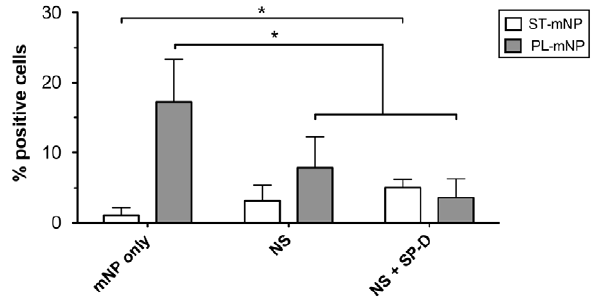
Figure 8. Association of nanoparticles with alveolar macro- phages in dependence on native surfactant. Starch- (ST) or Phosphatidylcholine-modified (PL) magnetite nanoparticles (mNP; 1.532 6 10 10 /ml) were incubated with alveolar macrophages (MH-S cells) for 90 min in absence (mNP only in buffer) or presence SP-A containing Native Surfactant (NS; 100 m g/ml total protein) with and without 6 m g/ ml SP-D (NS + SP-D). Per cent of cells with Fl-1 . 10 1 were considered as positive cells for nanoparticle association and uptake (% positive cells). Data shown as mean 6 SD (n $ 8). Asterisk indicates a significant difference with p , 0.05.